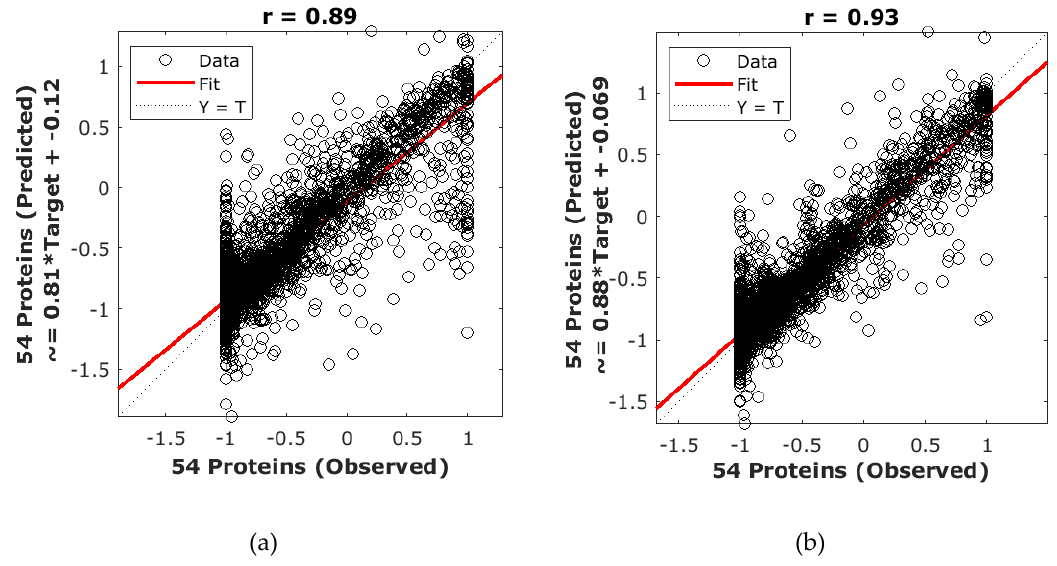
Figure 2. Overall artificial neural network models to predict 54 proteins in beer (Table 2), showing the correlation coe ffi cient (r) for ( a ) Model 1 using the absorbance values of near-infrared spectra (1600–2400 nm), and ( b ) Model 2 using the 15 physical parameters (color, foam, and bubbles) measured using RoboBEER (Figure 1).